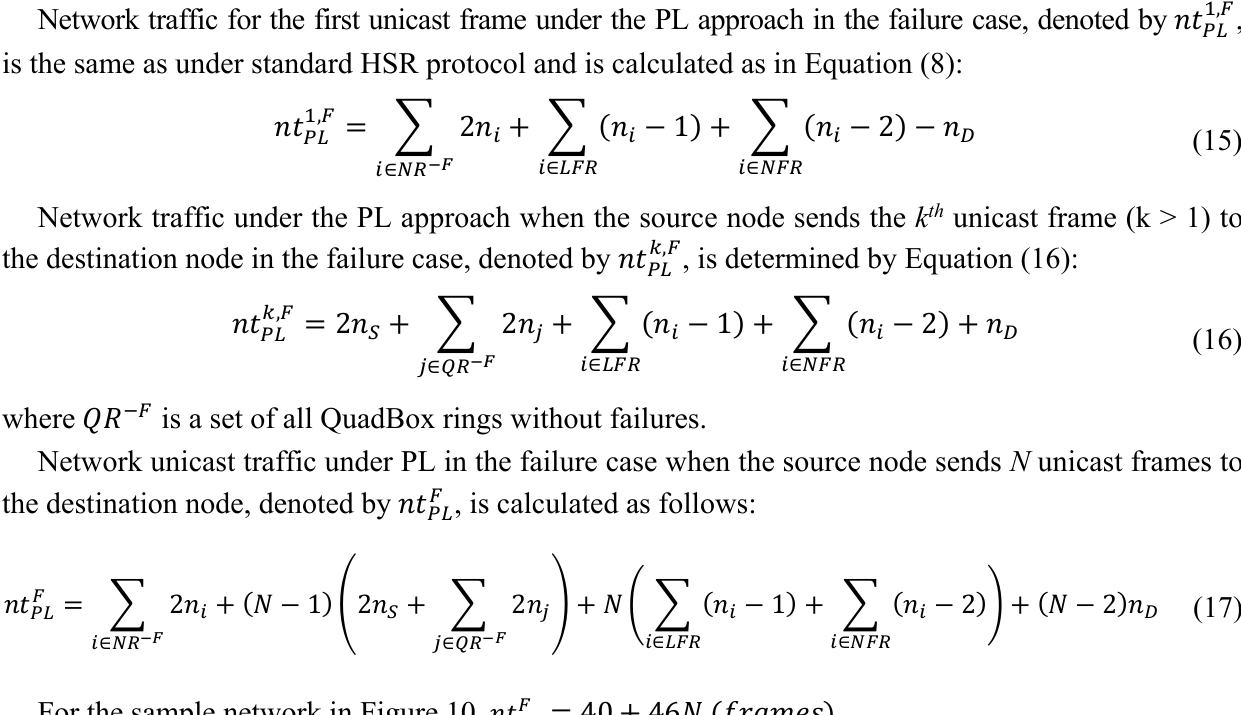
Figure 14. Network traffic under the PL approach in the failure